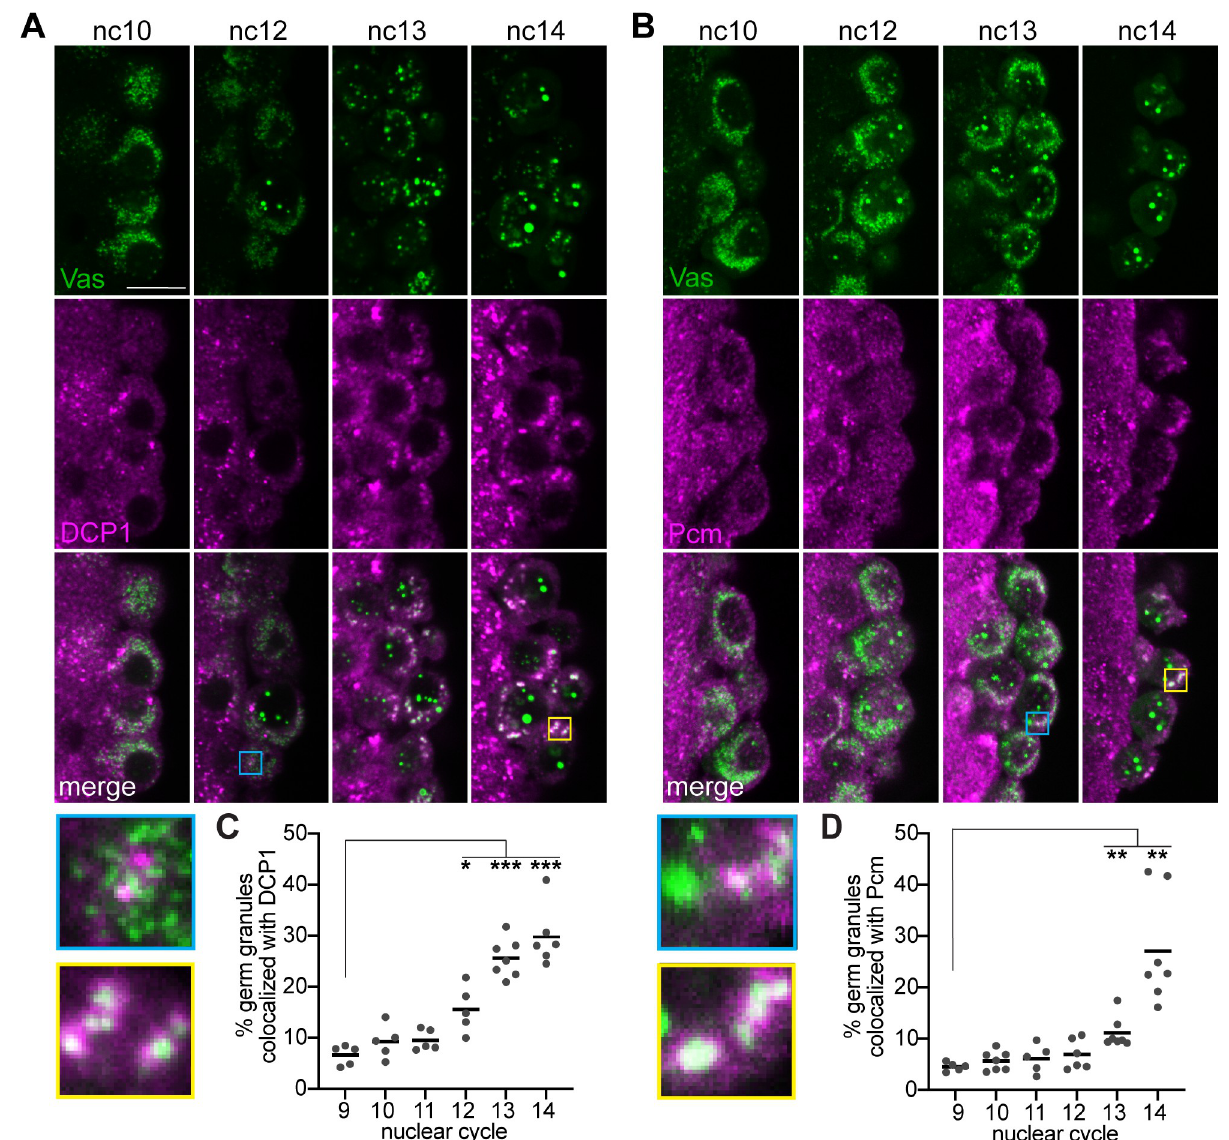
Fig 4. mRNA decapping proteins and degradation factors localize to germ granules prior to mRNA degradation. (A, B) Single confocal sections of the posterior region of syncytial blastoderm stage embryos expressing a vas-efgp transgene to mark the germ granules. Vas-EGFP (green) was detected by direct fluorescence together with anti-DCP1 immunofluorescence or anti-Pcm immunofluorescence (magenta). Enlargements of the boxed regions show examples of the earliest germ granule colocalization detected at nc12 or 13 (blue) and the strong colocalization at nc14 (yellow) for DCP1 (A) or Pcm (B). The percent of cytoplasmic Vas puncta that colocalize with DCP1 (C) and Pcm (D) puncta was quantified at each nc, n = 5–7 embryos per nc. Nuclear Vas puncta were masked using Imaris software. Values for individual embryos and means are shown. * p < 0.05, ** p < 0.01, *** p < 0.001 as determined by Welch ANOVA with Dunnett’s T3 post hoc test. Source data for the graphs in Fig 4C and 4D are provided in S1 Data. Scale bar: 5 μ m.